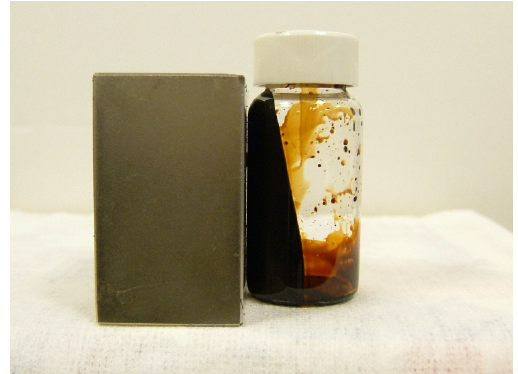
Figure 4. The magnetic effect on the